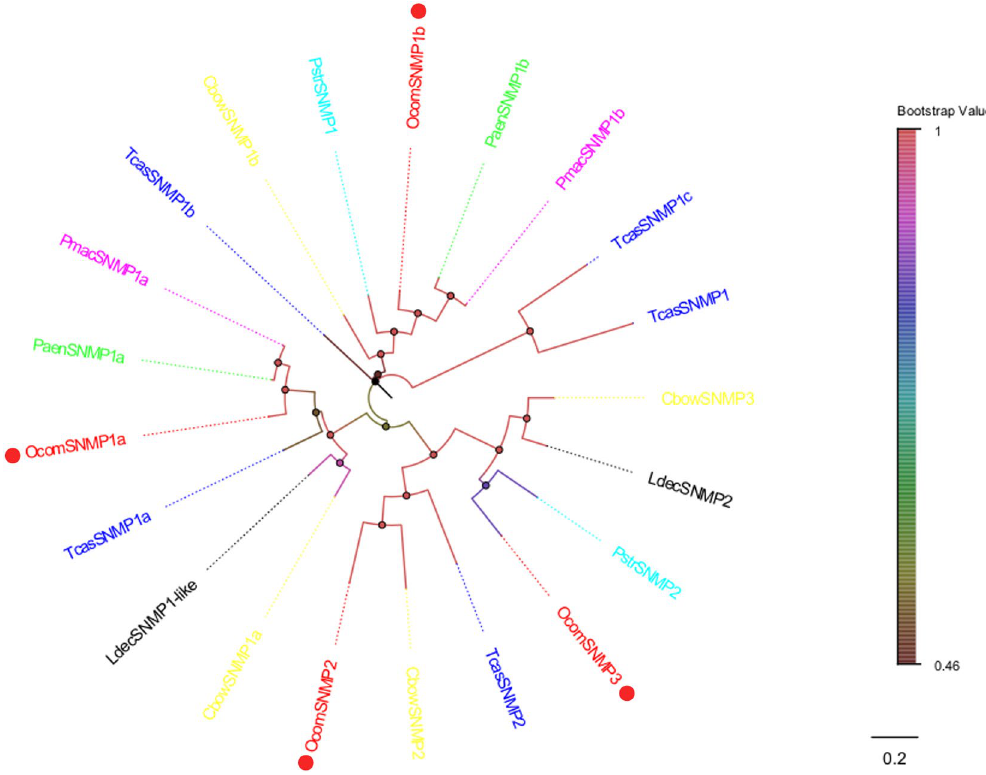
Figure 5. Neighbor joining phylogenetic tree of candidate OcomSNMPs with known Coleopteran SNMP sequences. Tcas, Tribolium castaneum (N = 5); Pmac, Pyrrhalta maculicollis (N = 2); Paen, Pyrrhalta aenescens (N = 2); Cbow, Colaphellus bowringi (N = 4); Ldec, Leptinotarsa decemlineata (N = 2); Pstr, Phyllotreta striolata (N = 2). Candidate OcomSNMPs were indicated by red